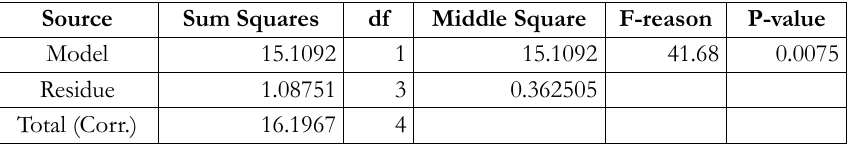
Table 7. Statistical analysis of variance - Source Statgrafics Centurion